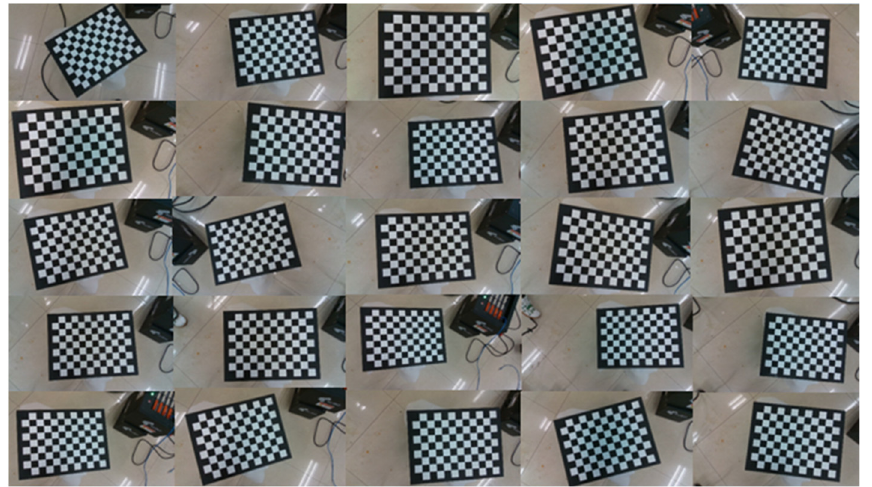
Figure 10. Calibration board images taken from different perspectives.